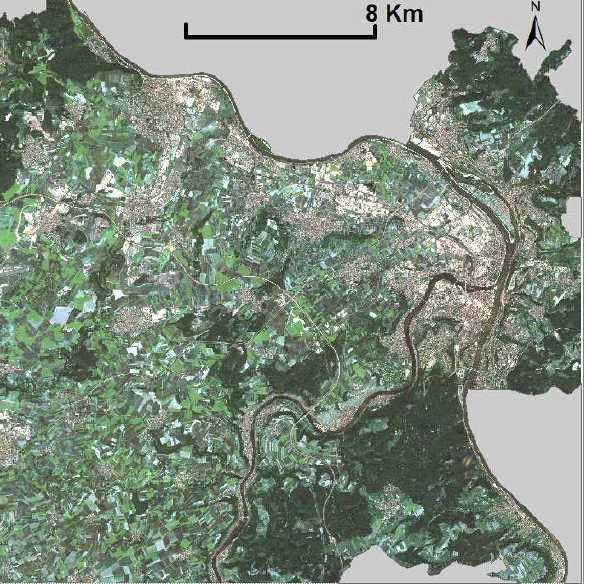
Figure 1: The geographical extent of study area